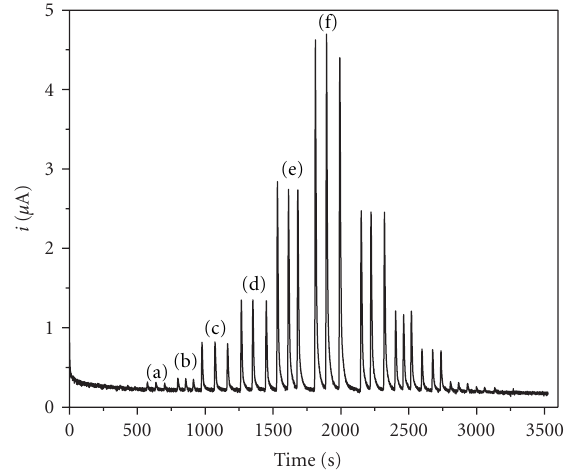
Figure 3: FIA signals obtained using the electrolyte solution as carrier stream, consisting of 0.1molL − 1 K 2 SO 4 and 5.0 × 0 − 4 molL − 1 FeSO 4 · 7H 2 O. The concentrations evaluated were: (a) 5.0 × 10 − 5 molL − 1 (b) 5.0 × 10 − 4 molL − 1 (c) 1.0 × 10 − 3 molL − 1 ; (d) 1.0 × 10 − 2 molL − 1 (e) 2.5 × 10 − 2 molL − 1 and (f) 5.0 × 10 − 2 molL − 1